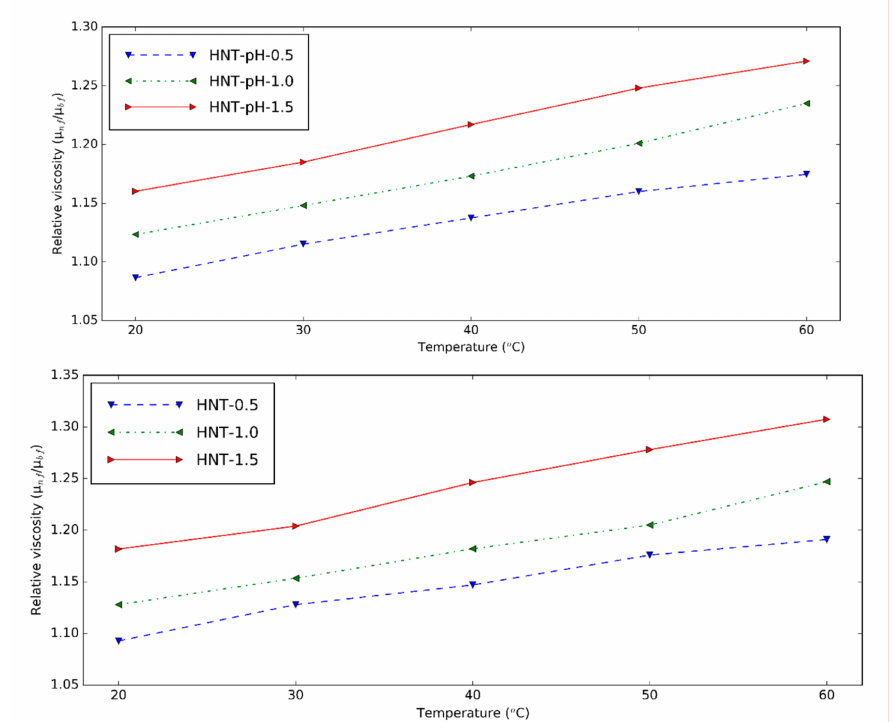
Figure 7. Relative viscosity of HNT nanofluids at di ff erent temperatures (upper: changing pH,